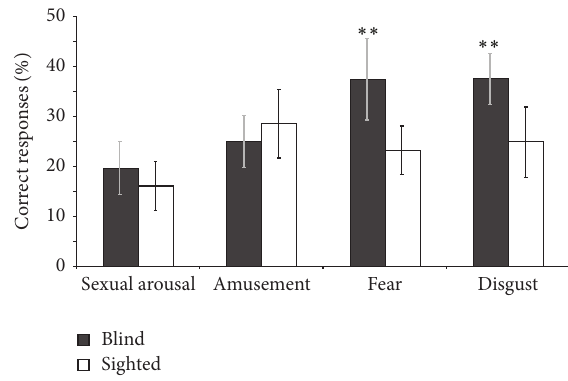
Figure 4: Results of the odour identification task. Congenitally blind participants had a strong tendency to be better at identifying fear and disgust, but none of the groups were above chance level (20%) for amusement and sexual arousal. Data present mean ± SD. ∗∗ 𝑃 < 0.01 .